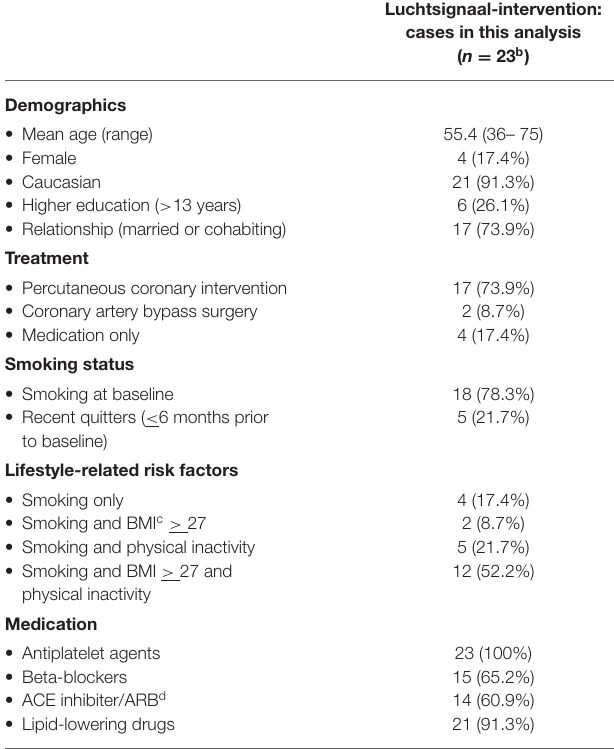
TABLE 4 | Baseline characteristics a